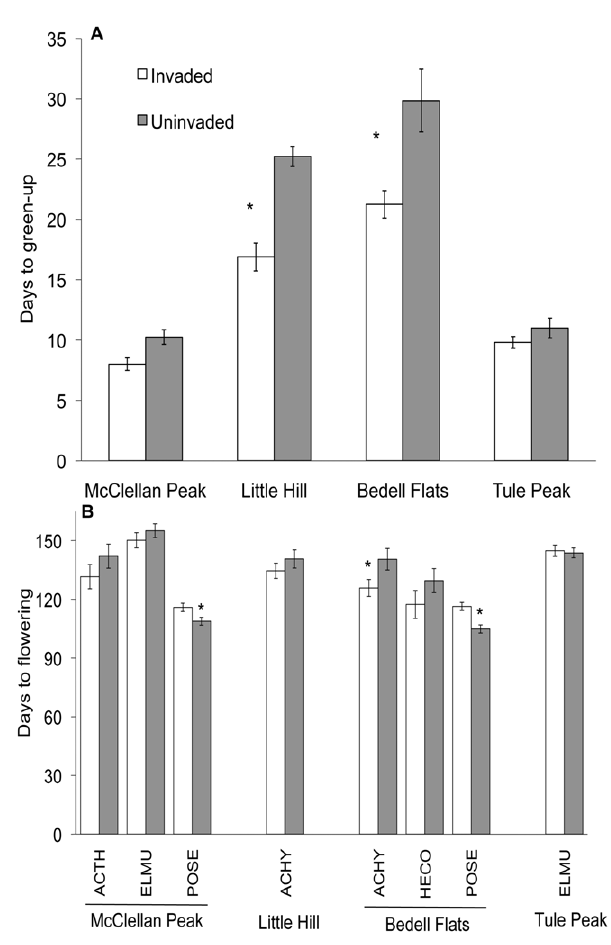
Figure 3. Phenology of invaded and uninvaded populations. Mean number of days before growth commenced for plants that were not green at the time of collection from invaded and uninvaded communities from Bedell Flats, Little Hill, McClellan Peak, and Tule Peak (a) and the number of days until flowering for each species from invaded and uninvaded communities at each sampling location (b). Asterisk indicates significant differences between invaded and unin- vaded communities ( P , 0.05) based on post-hoc contrasts. POSE = Poa secunda , ACHY = Achnatherum hymenoides , HECO = Hesperostipa comata , ELMU = Elymus multisetus , and ACTH = Achnatherum thurberianum.